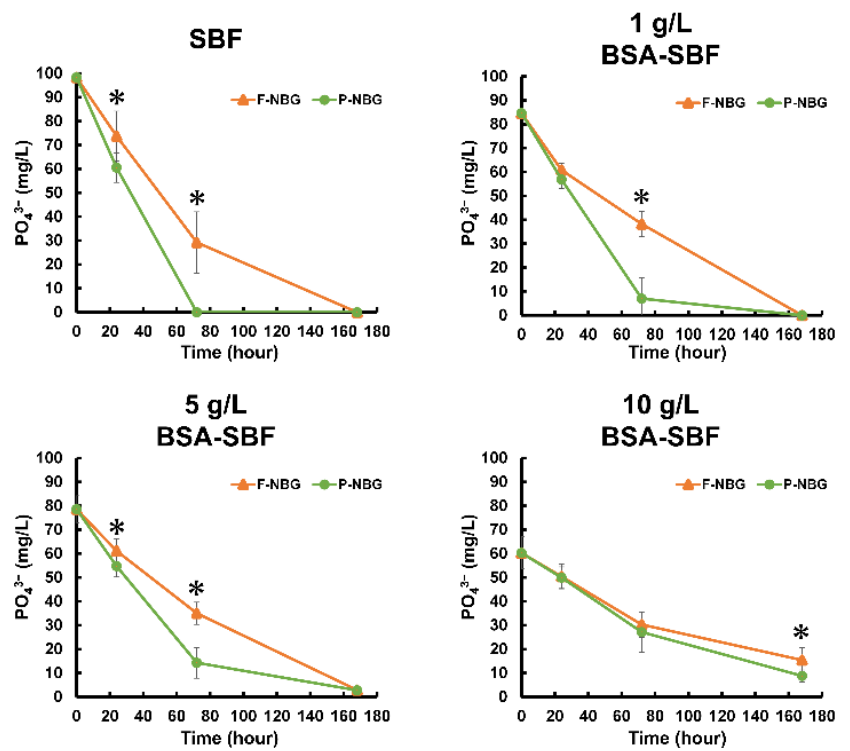
Figure 2. Phosphate ion (PO 4 3− ) concentration in simulated body fluid (SBF) or 1-, 5-, or 10-g/L bovine serum albumin-containing SBF (BSA-SBF) after the immersion of flowable and putty-form Nishika Canal Sealer BG Multi (F-NBG and P-NBG). Asterisks indicate p < 0.05 (unpaired t -test, n = 6).